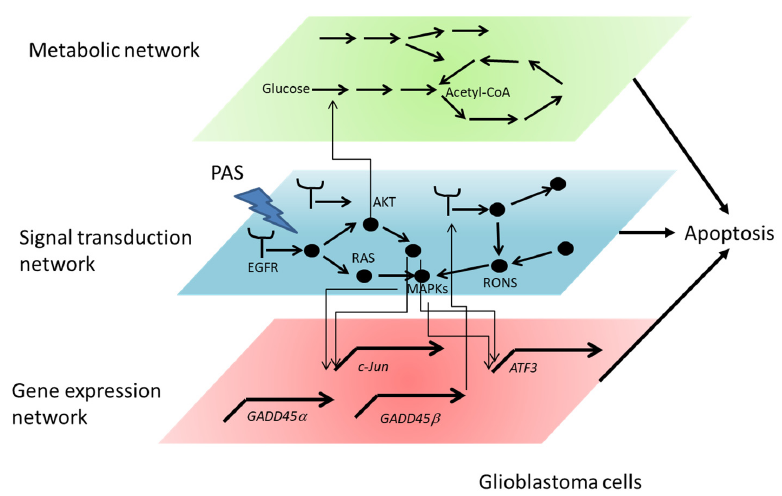
Figure 7. Gene expression network, signal transduction network, and metabolic network affected by PTS.